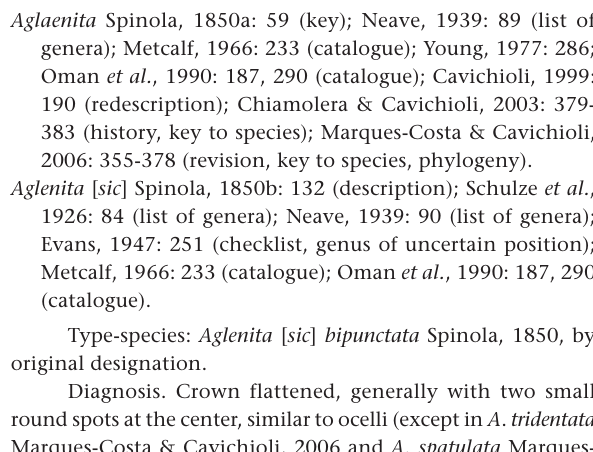
Diagnosis. Male genitalia: pygofer (Fig. 5) enlarged ba- sally, narrowed towards apex, bearing apical bifurcated pro- cess, branches of process pointed and sclerotized, upper branch longer than tooth-like lower one; aedeagus (Figs 10 and 11) without processes, basal half enlarged and membranous, shaft curved dorsally, narrowed towards apex, ventral margin with- out teeth.